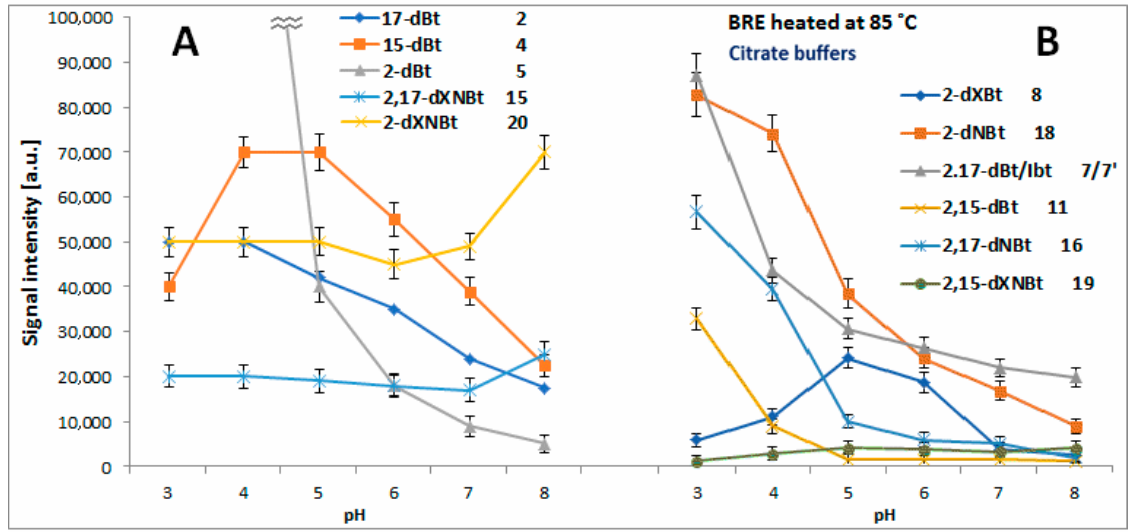
Figure 11. LC ‐ MS signal levels of prominent decarboxylated/dehydrogenated betanin derivatives detected after 45 min extract heating at 85 °C in citrate buffer solutions in dependence on pH. ( A : 2, 4, 5, 15 and 20; B : 8, 18, 7/7’ 11 16 and 19).